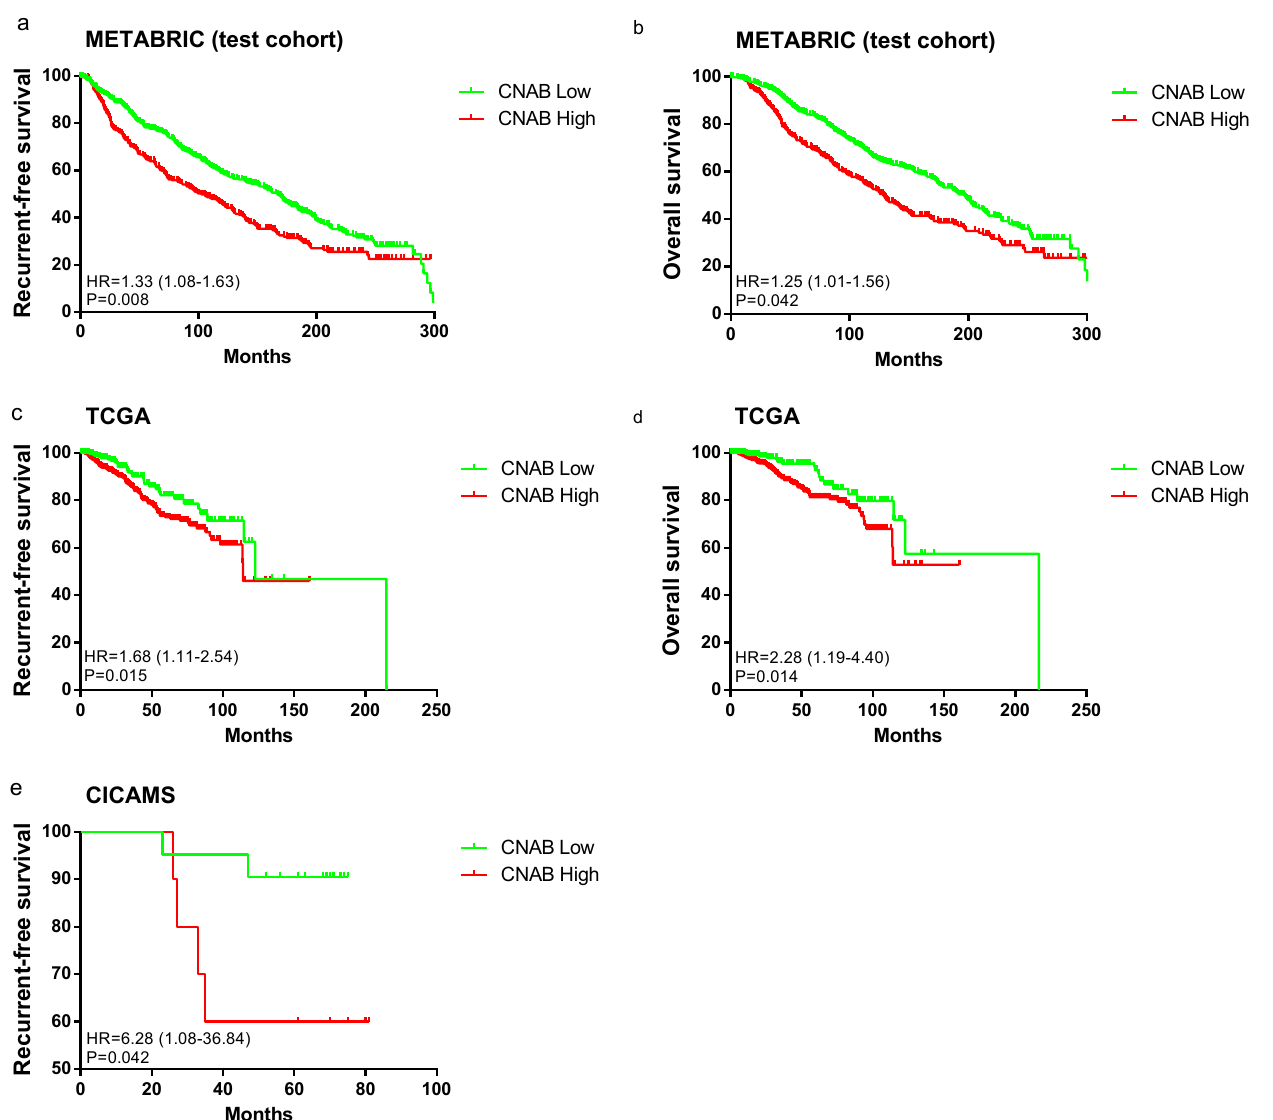
Figure 2. Survival analysis on relapse-free survival and overall survival of patients in the ( a , b ) METABRIC test cohort, ( c , d ) TCGA, and ( e ) CICAMS between the CNAB-high group and CNAB-low